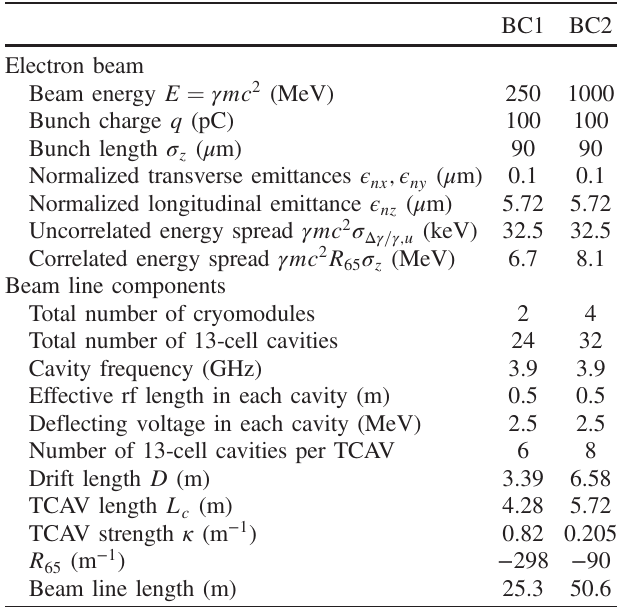
TABLE I. TCBC parameters for the MaRIE x-ray FEL.